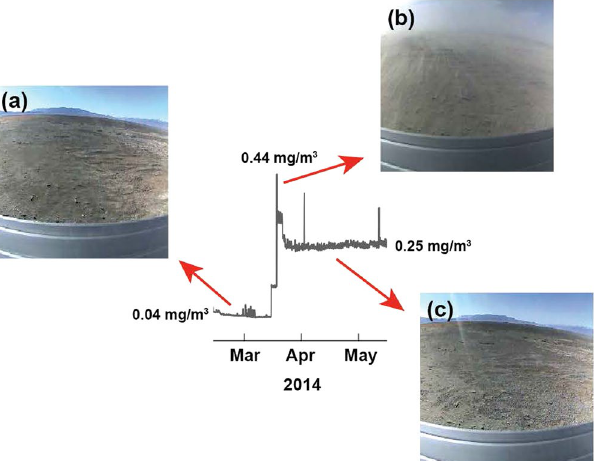
Figure 3. Images taken before ( a ), during ( b ) and after ( c ) a saltation event in 2014 shows that the abrupt increase in the aerosol concentration at the field site was caused by the breaking of surface salt crusts. The data in the center is a snap shot of that presented in Fig. 1. This major dust-lifting event caused an abrupt increase in the PM2.5 aerosol